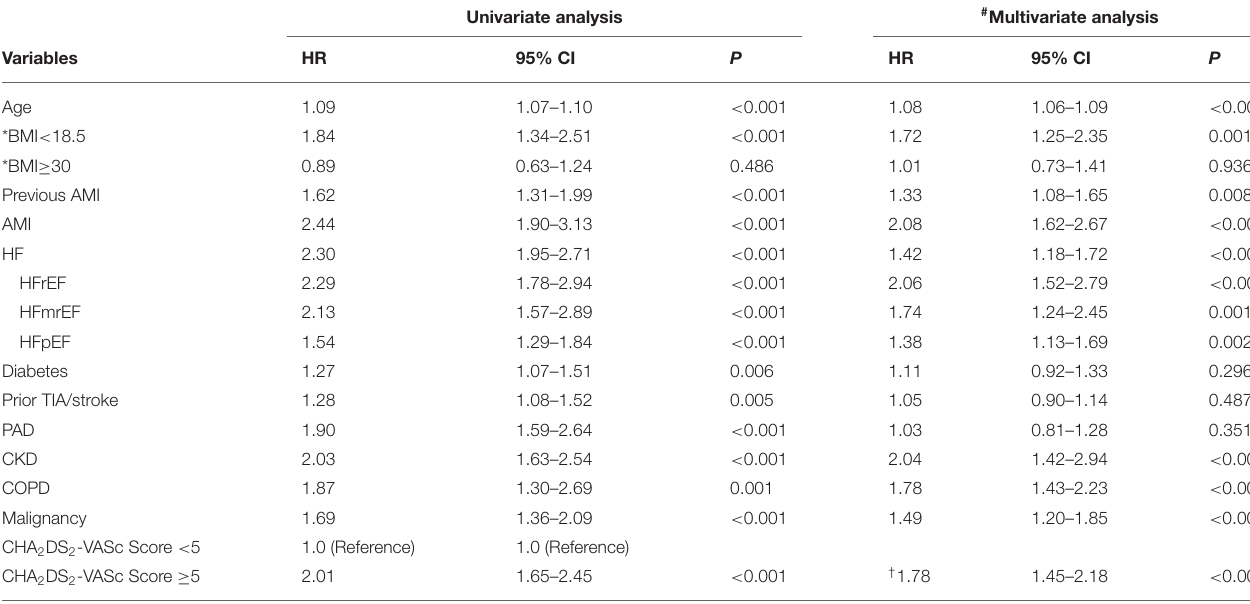
TABLE 2 | Predictors of mortality in elderly patients with CAD and AF by Cox regression analysis.